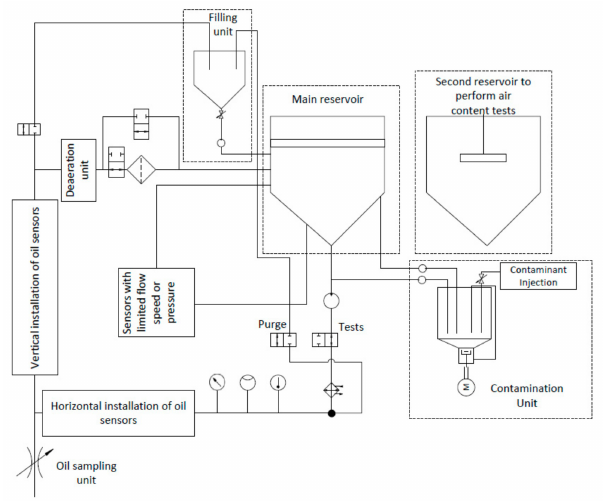
Figure 1. Layout of the oil sensor test bench at Fraunhofer